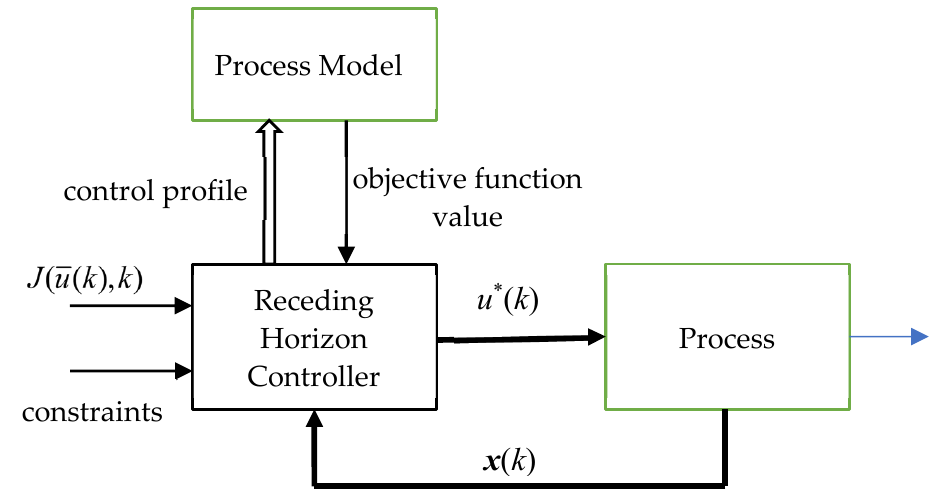
Figure A1. Closed-loop control structure.